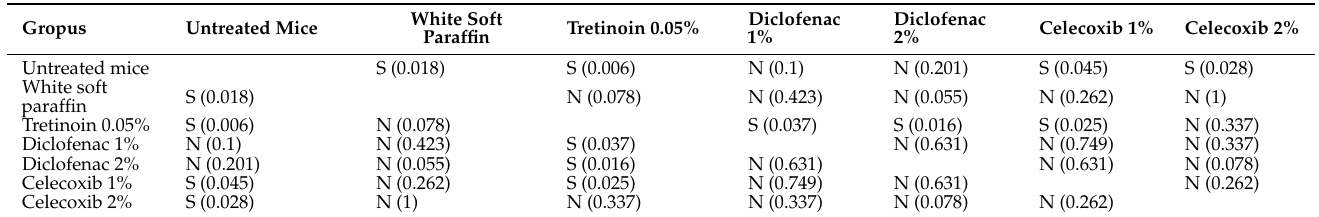
Table 3. Multiple statistical comparisons regarding mean epidermal thickness using Kruskal– Wallis